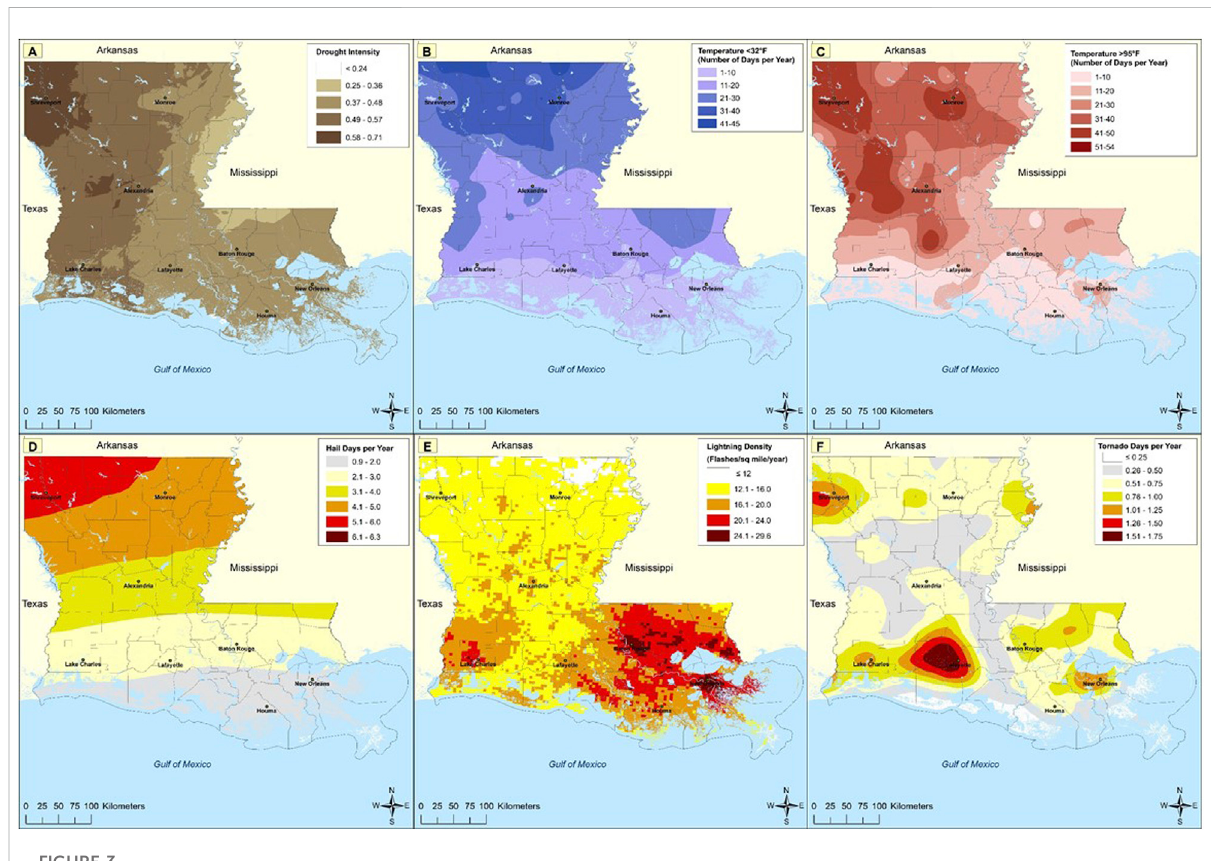
FIGURE 3 As in Figure 2, but for projected future hazard intensity in Louisiana by